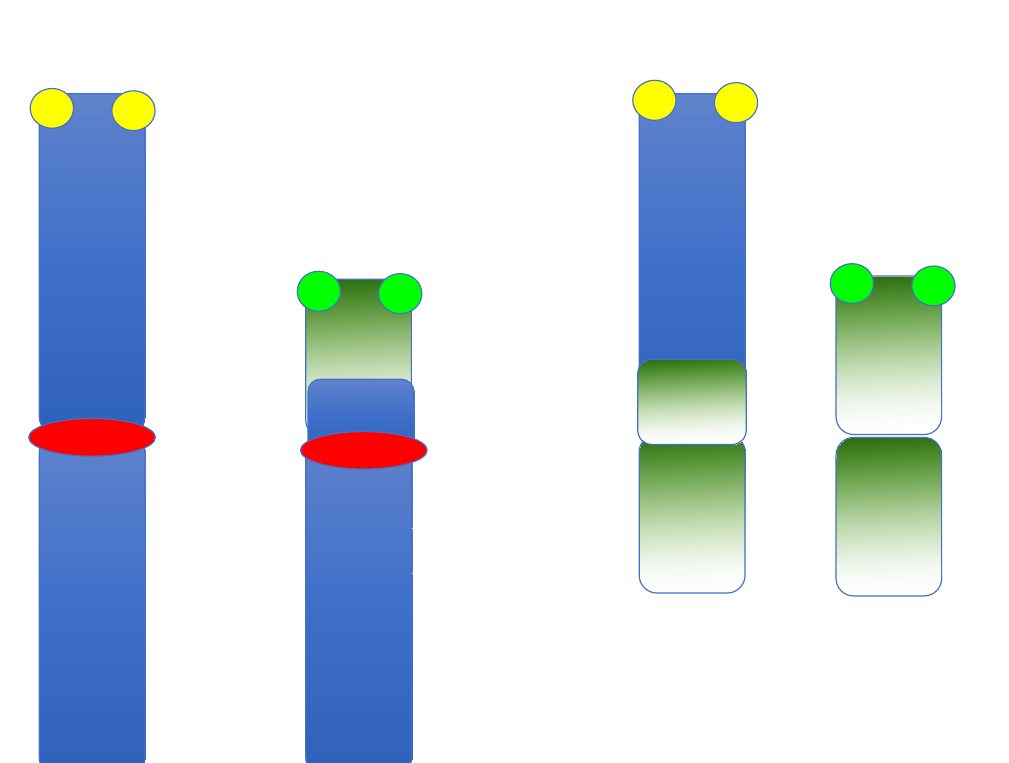
Figure 3. FISH detection protocol probably first devised by Joy Delhanty. At least three probes are required, two of which must be on either side of one of the chromosomal breakpoints. The availa ‐ bility of commercial probes in the late 1990s and early 2000s meant that centromeric and sub ‐ telo ‐ meric probes were often used, typically in red, green, and yellow colors. Balanced and unbalanced segregation patterns could be observed in the interphase nuclei of fixed preimplantation methods.